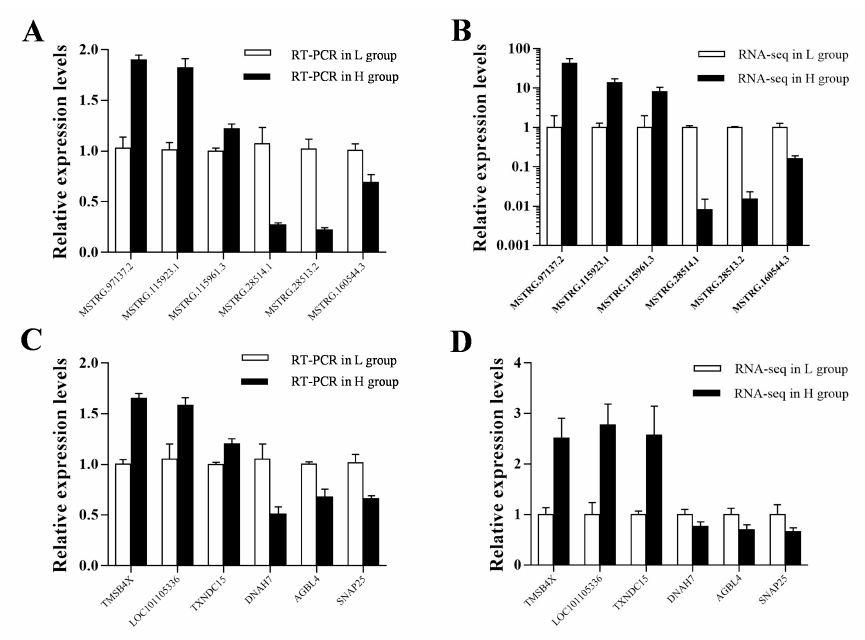
Figure 4. The verification of expression level of DE lncRNAs and DE mRNAs in different groups. ( A , B ) The relative expression level of 6 DE mRNAs in different groups determined by qRT-PCR and RNA-Seq, respectively. TMSB4X , thymosin β 4 X-linked; TXNDC15, thioredoxin domain containing 15; DNAH7, dynein axonemal heavy chain 7; AGBL 4, ATP/GTP binding protein like 4; SNAP25, synaptosome associated protein 25. ( C , D ) The relative expression level of 6 DE lncRNAs in 2 groups determined by qRT-PCR and RNA-Seq, respectively. The relative expression level of DE lncRNAs and DE mRNAs in the pituitary was determined by qRT-PCR and normalized to the expression amount of HPRT1 . The qRT-PCR data were represented as the mean ± SEM of three biological and technical replicates. The RNA-Seq data represented the FPKMs of each transcript.